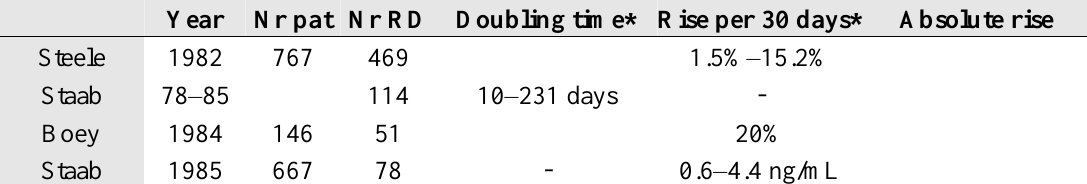
Table 4. Quantitative rise of CEA in patients with recurrent